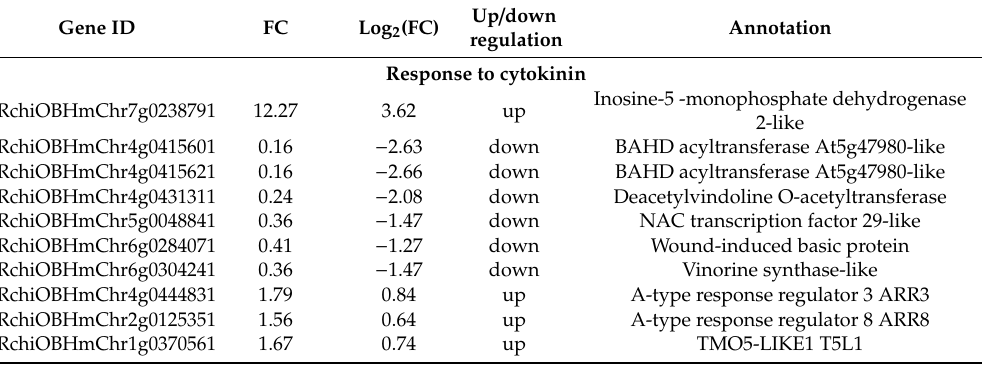
Table 4. DEGs involved in the cytokinin signaling